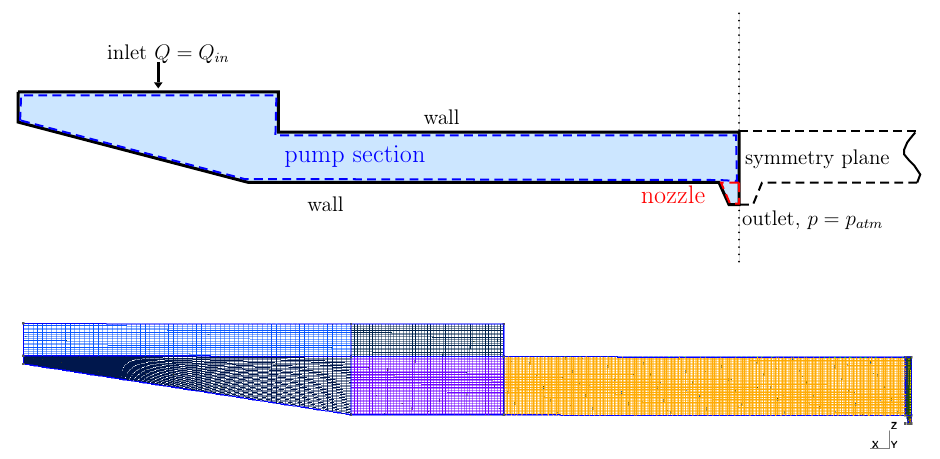
Figure 6. ( Top ) Computational domain and boundary condition for fluid section of the ink channel. The fluid domain is partitioned into two sections, namely, pump and nozzle, to quantify the LEM parameters M P , M A , R P , and R N . ( Bottom ) A typical mesh for simulation where the middle pump section (in yellow) is uniformly meshed with resolution of ∆ x , ∆ y , and ∆ z .